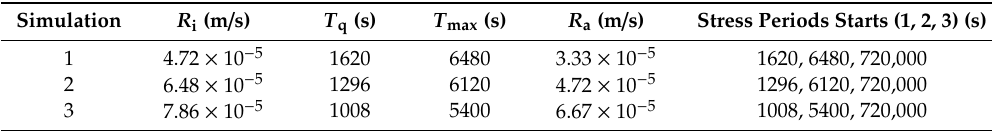
Table 3. The initial recharge rate ( R i ), time of recharge flux ( T q ), time of observed maximum thickness ( T max ), adjusted recharge ( R a ) rates, and stress period times for the numerical model simulations.